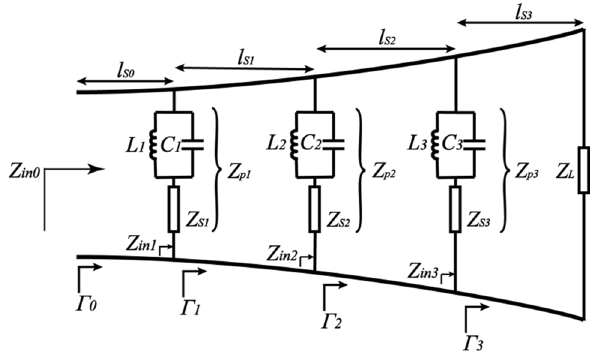
Figure 1. Equivalent transmission line of the reconfigurable Vivaldi